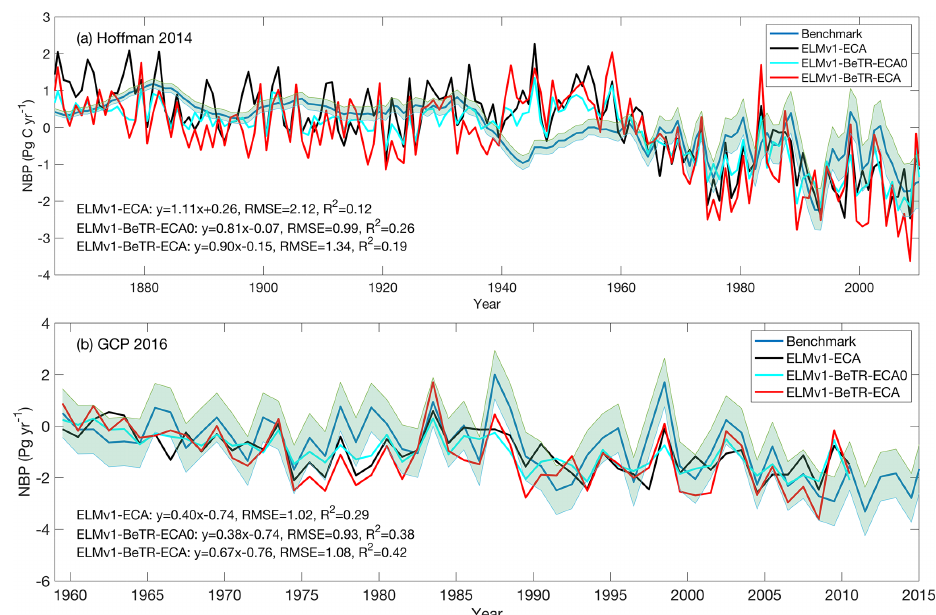
Figure 4. Benchmark of simulated NBP with two global syntheses (a) compared with data from Hoffman et al. (2014) and (b) compared with data from Le Quere et al. (2016). In the linear regression, x is the benchmark and y is the model output.